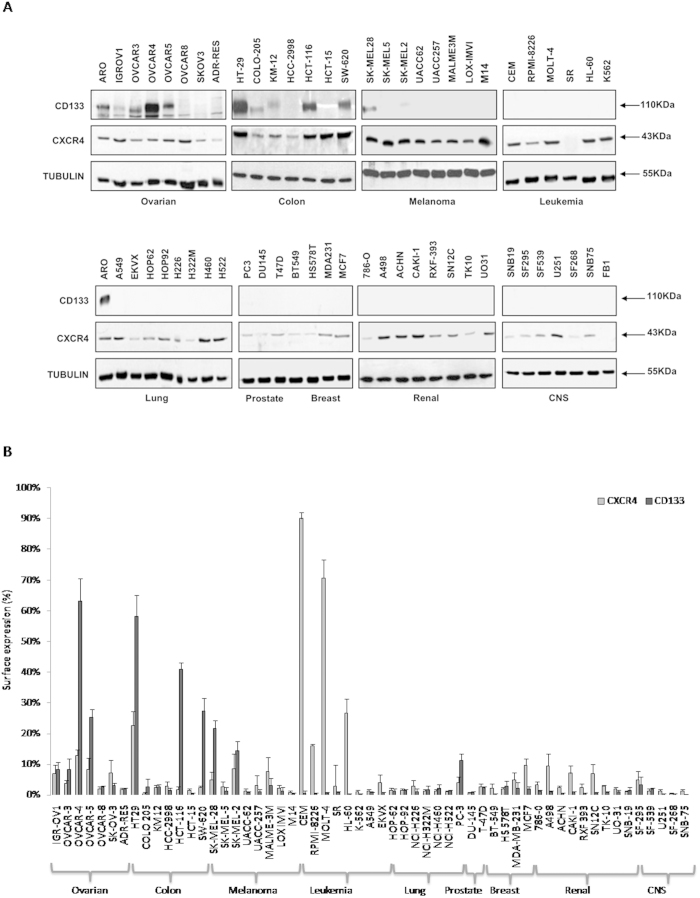
CXCR4 and CD133 protein expression in NCI 60 cell lines. (A) CXCR4 and CD133 protein level was evaluated through Immunoblotting. All gels had been run under the same experimental conditions. (B) Bar plots summarizing Flow Cytometry analysis for CXCR4 and CD133 protein level in the 60 cell lines from the Drug Screen Program.